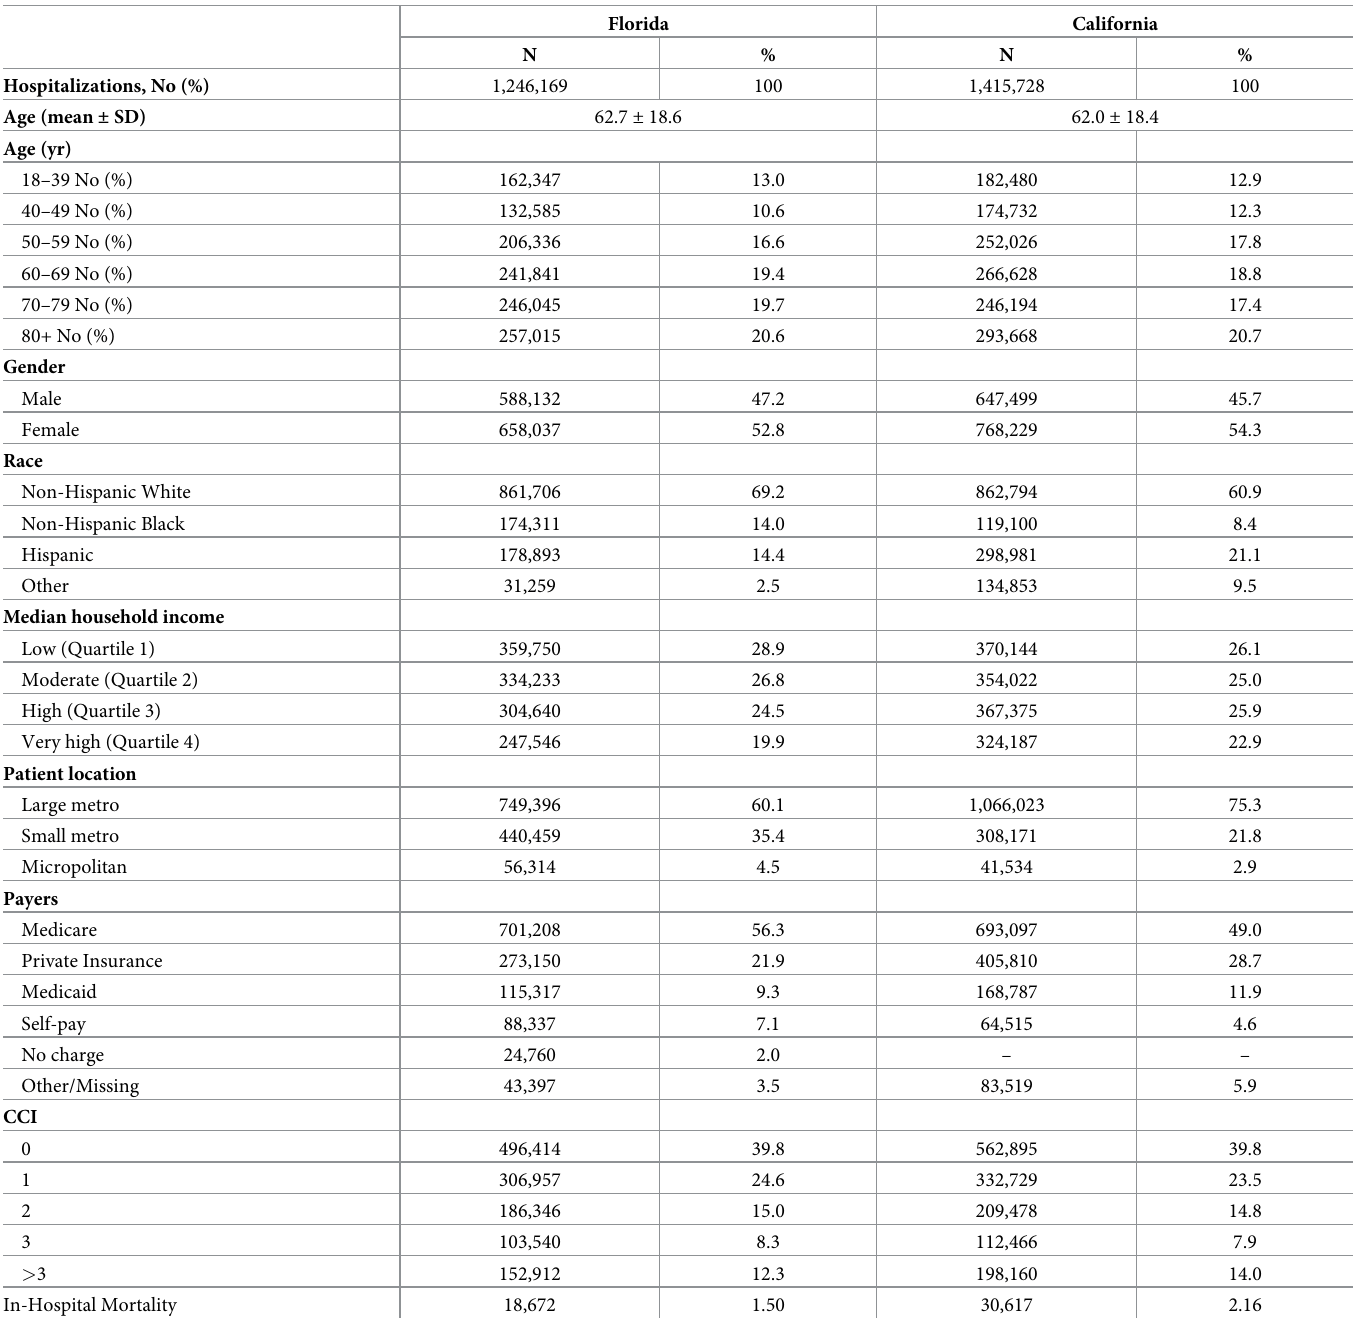
Table 1. Patient characteristics in Florida 2014 and California